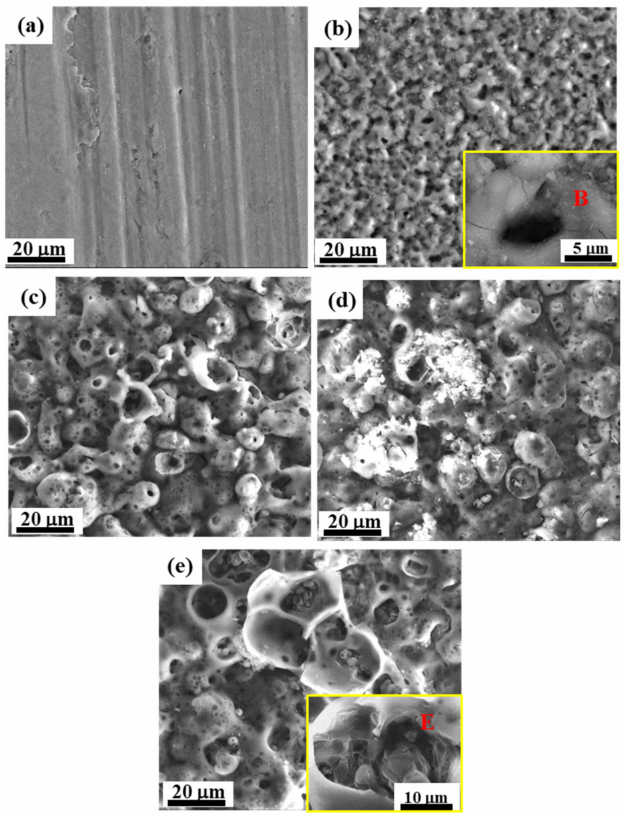
Figure 3. Surface morphology of PEO coating at different stages: ( a ) stage I; ( b ) stage II (Type B discharge framed by the yellow line); ( c ) stage III; ( d ) stage IV; ( e ) stage V (Type E discharge framed by the yellow line).